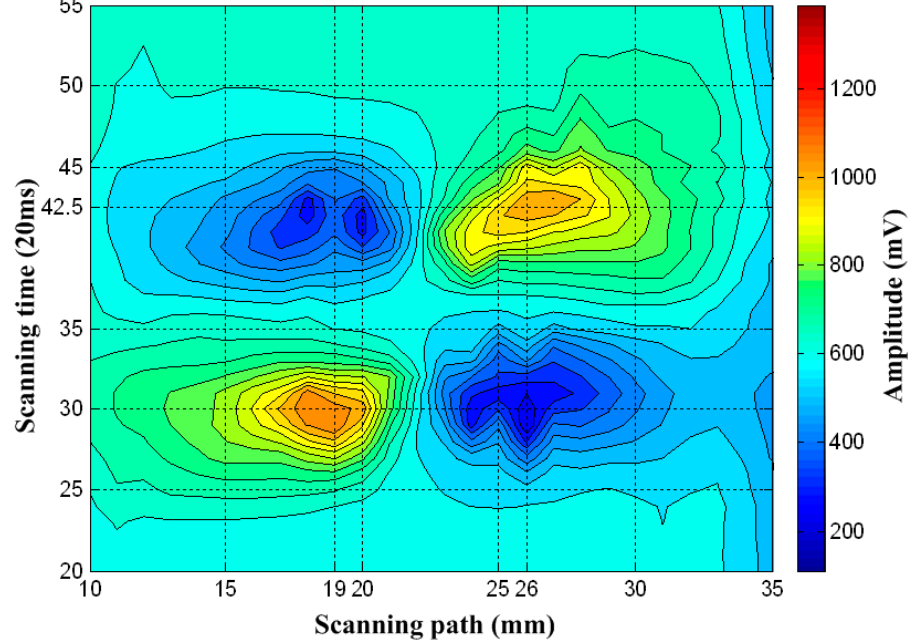
Figure 11. C-scan outline images of defect 1 in the direction of the exciting current. Applied Science. 2018 , 9 , x FORPEERREVIEW